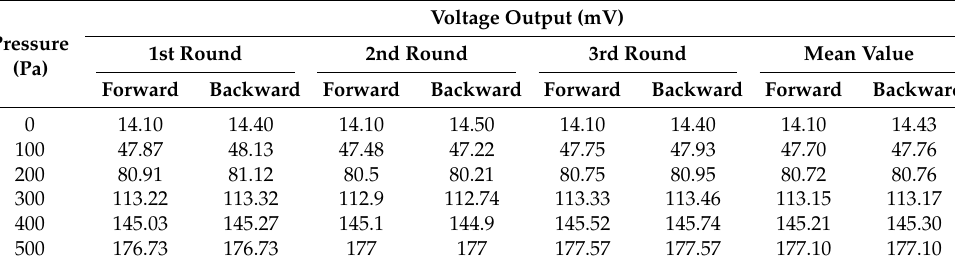
Table 1. Calibration data for the improved diaphragm I.